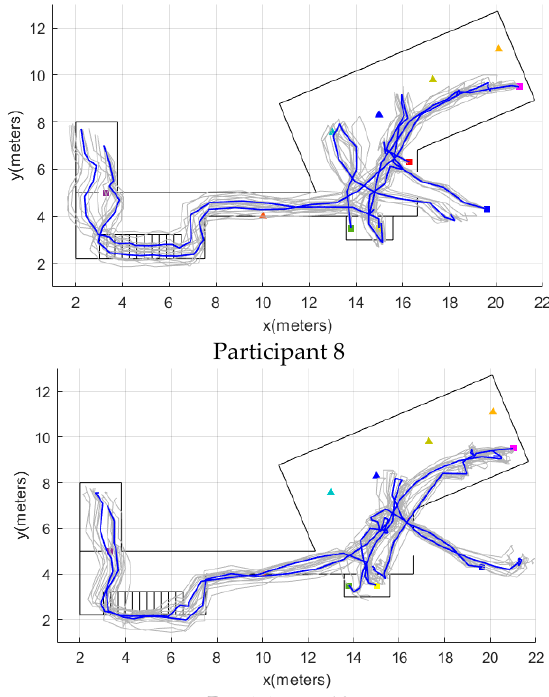
Figure A3. Indoor localization results (control group, participants 1–6).